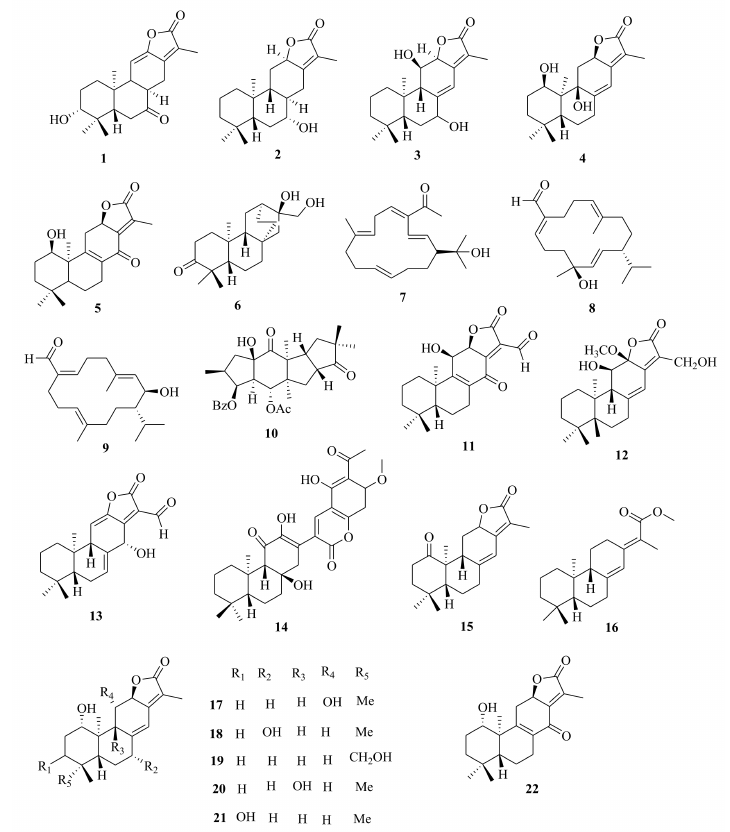
Figure 1. Chemical structures of abietane and atisane